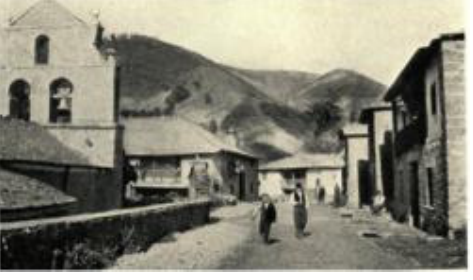
Unidentified photographer, A Little Town in Leon , from Georgiana Goddard King, The Way of Saint James , vol. 2 (New York: G.P. Putnam’s Sons, 1920), page 235 (photo: